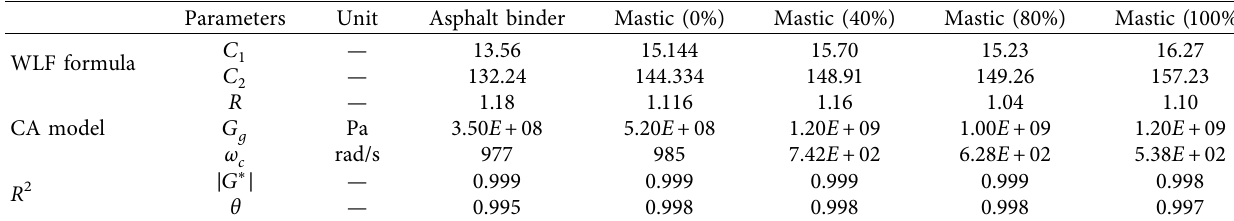
Table 3: Parameters of the WLF formula and CA model for asphalt binder and mastics.